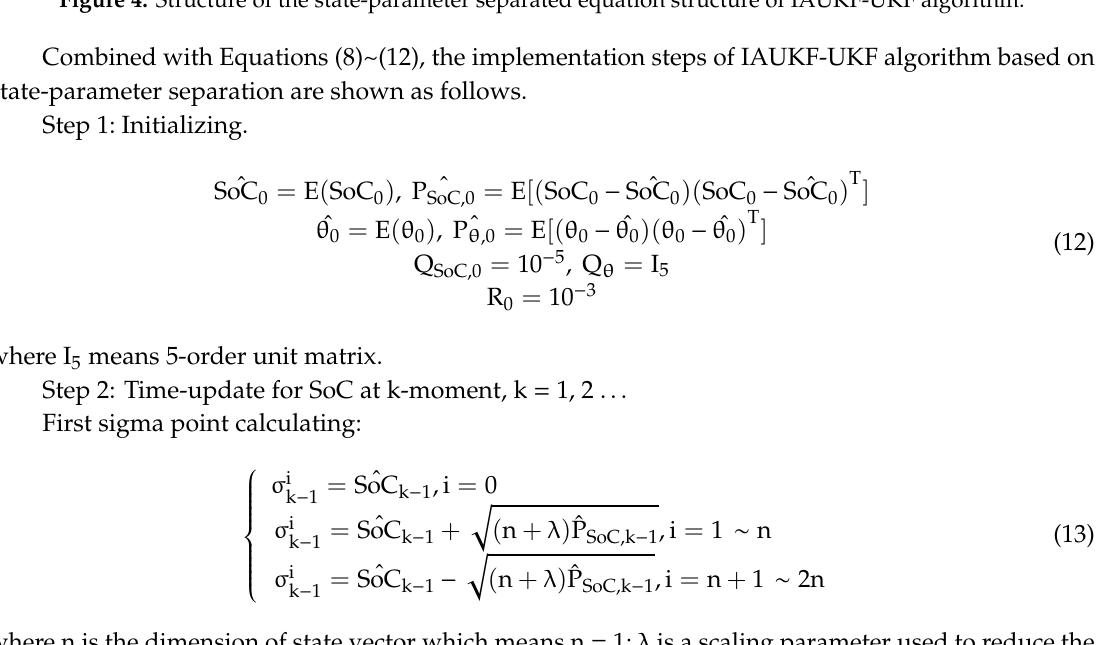
Figure 4. Structure of the state-parameter separated equation structure of IAUKF-UKF